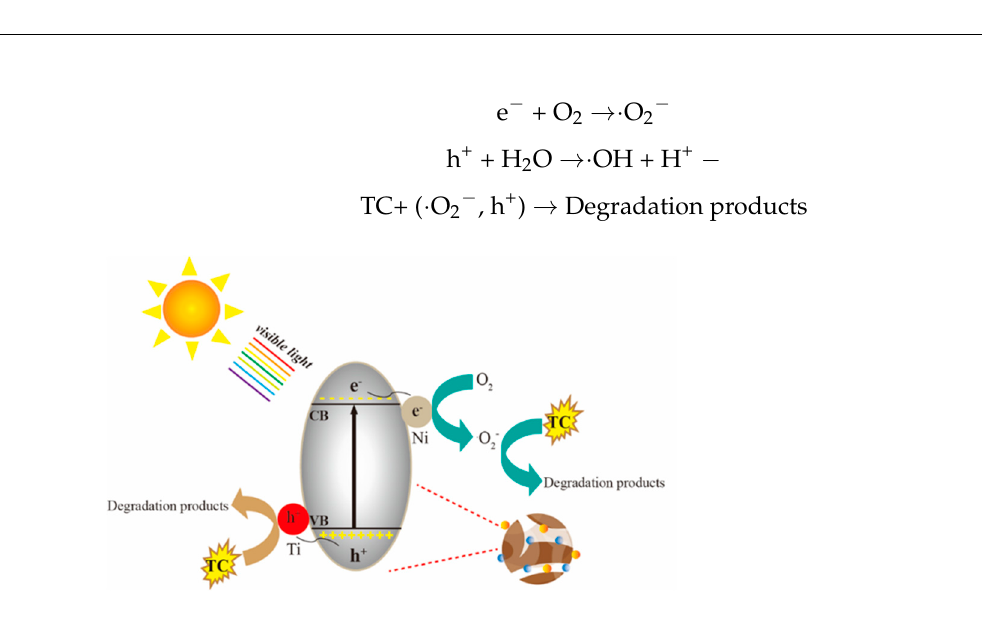
Figure 14. Possible mechanism of the enhanced photocatalytic activity during the photocatalytic degradation of TC over Ni/Ti-Bi 2 WO 6 photocatalyst under visible-light irradiation.